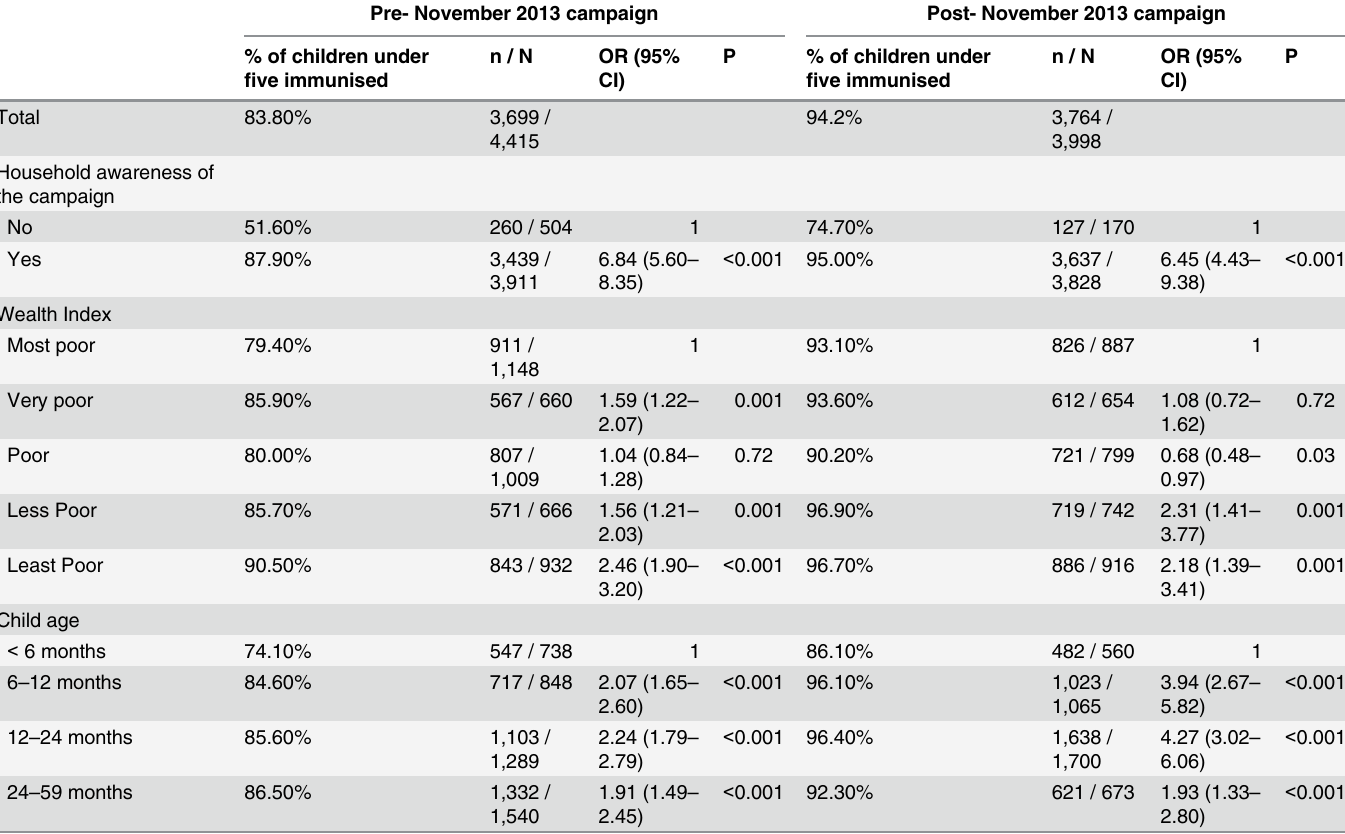
Table 2. Univariable associations of reported polio immunisation coverage with household awareness of the campaign, socio-economic index and child age (pre- and post- November 2013 polio campaign).